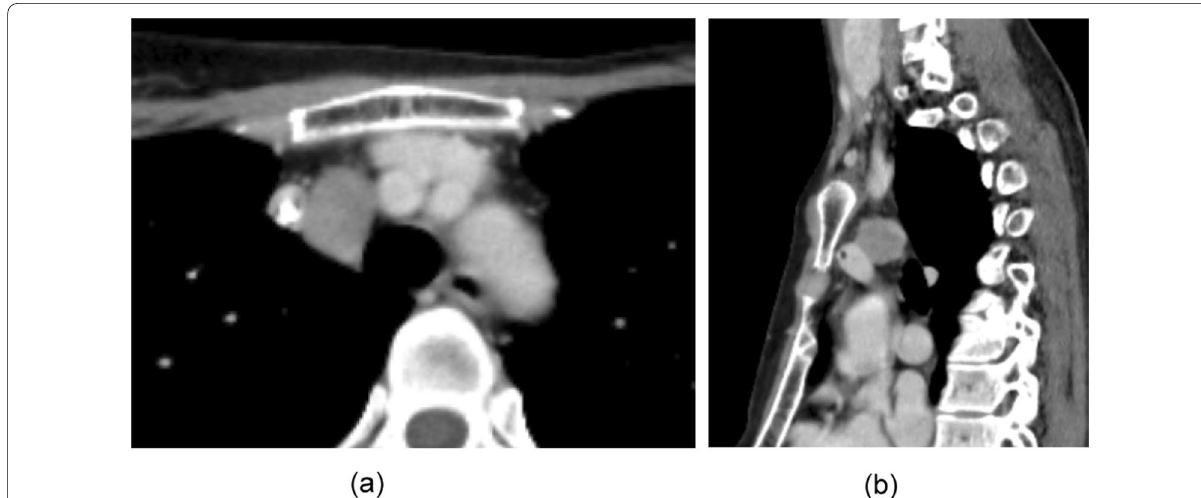
Fig. 1 A chest CT scan obtained at 4 years after the patient’s breast surgery. A mediastinal nodule (diameter: 23 mm) was detected on the horizontal ( a ) and sagittal ( b ) views